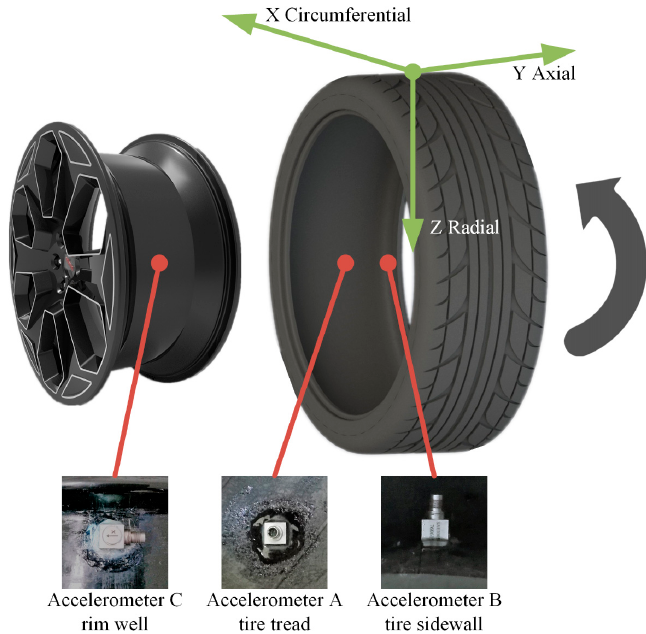
Figure 2. Accelerometer setup and tire coordinates.